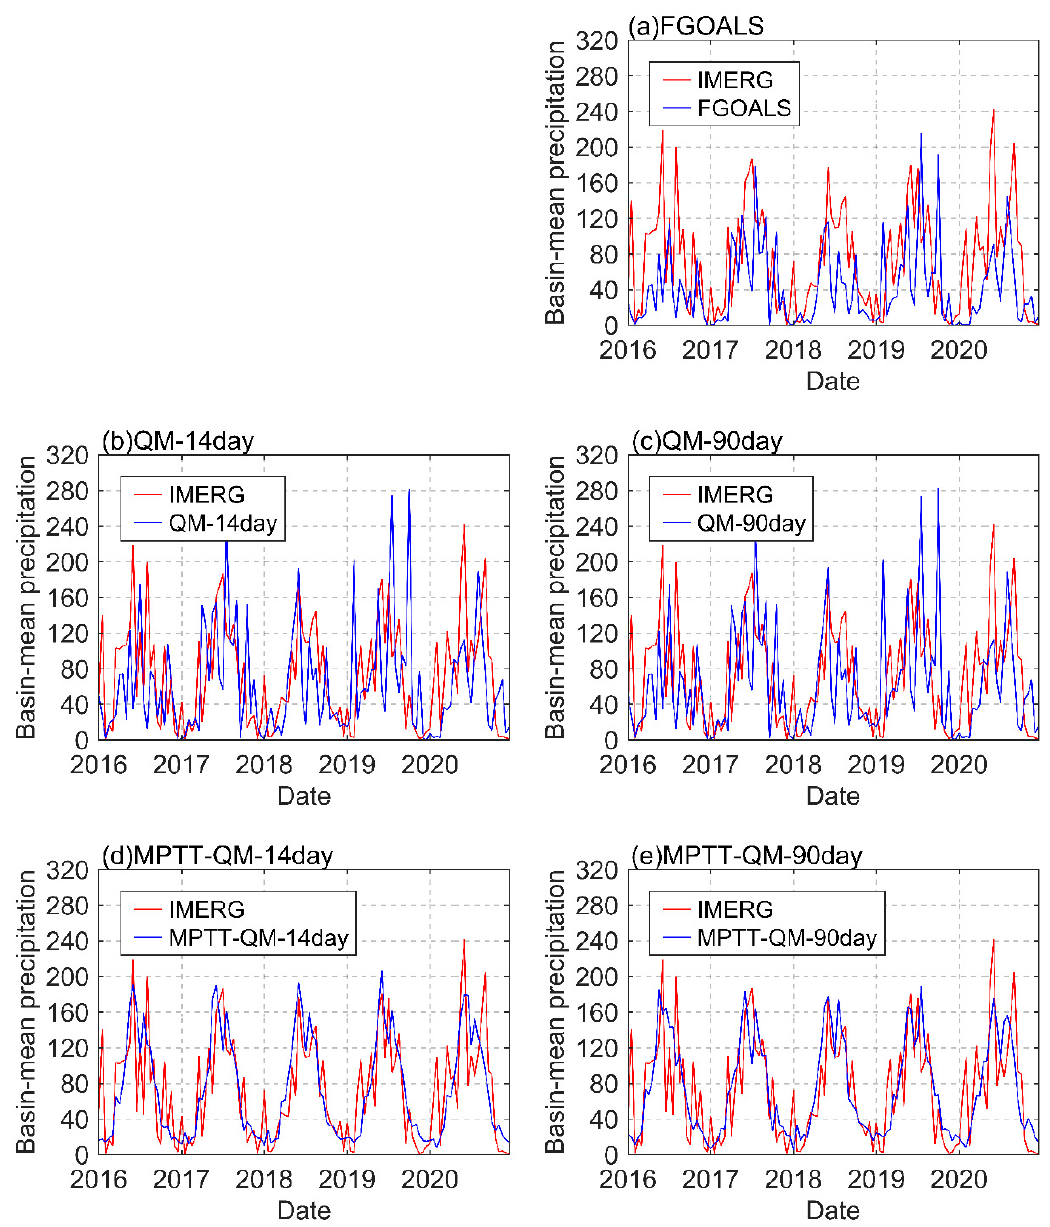
Figure 5. Time series distribution of average precipitation in the PRB on a half-month scale from 2016 to 2020. The red line represents the IMEGR, and the blue line in figure ( a – e ) represents the FGOALS, QM-14day, QM-90day, MPTT-QM-14day, and MPTT-QM-90day, respectively (unit: mm).